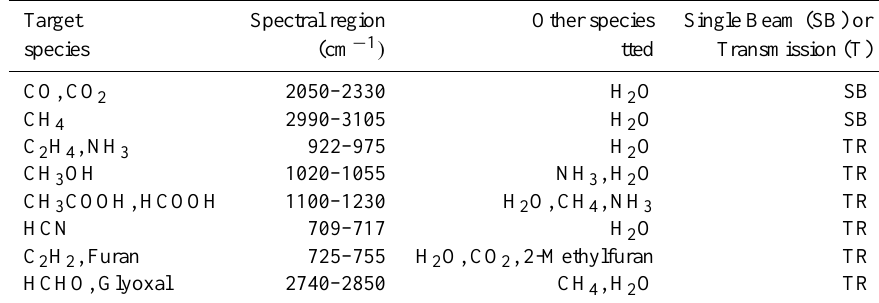
Table A1. Spectral regions used to retrieve excess mixing ratios reported in this work.